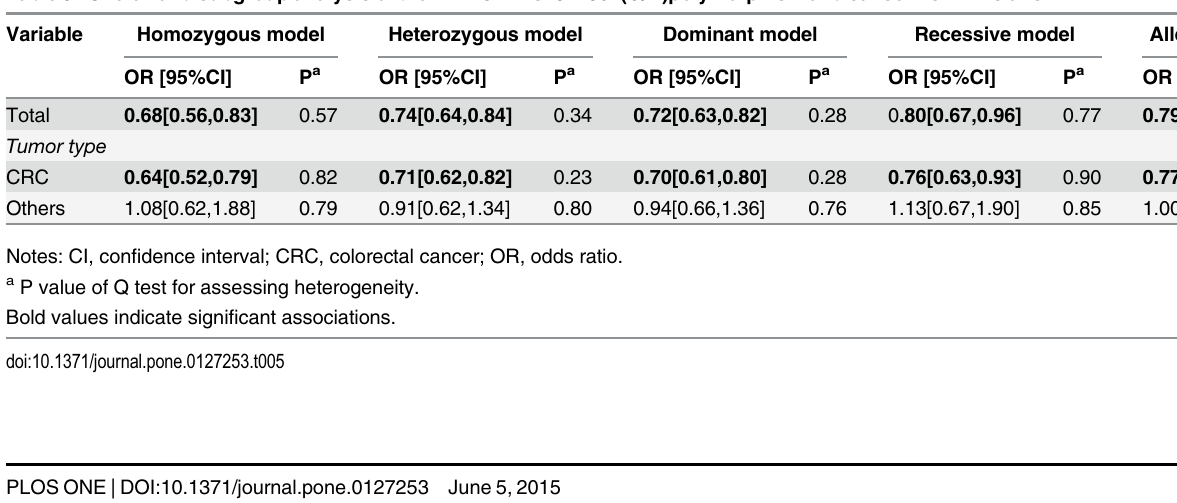
Table 5. Overall and subgroup analysis of the ADIPOR1 rs1342387(G/A)polymorphism and cancer risk in Asians. Variable Homozygous model Heterozygous model Dominant model Recessive model Allele contrast model